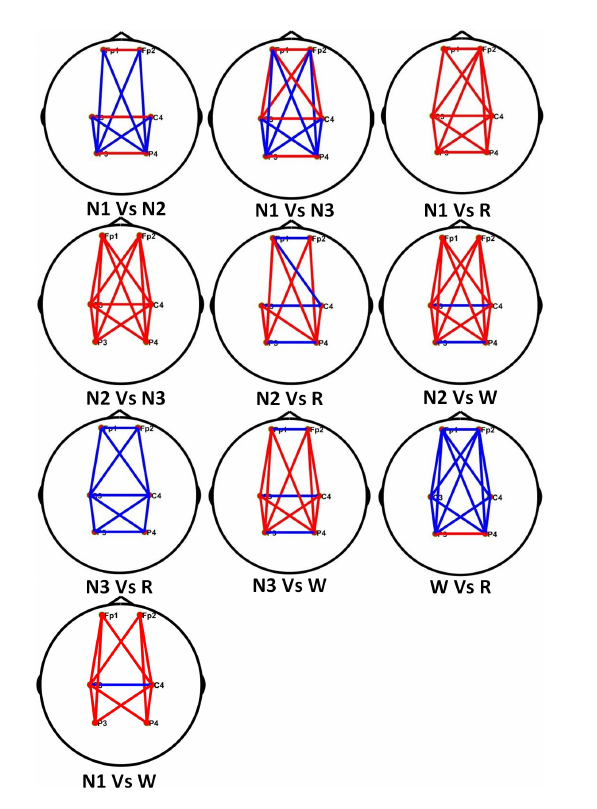
FIGURE9 Comparison of brain network connectivity in different sleep stages in the α frequency band.